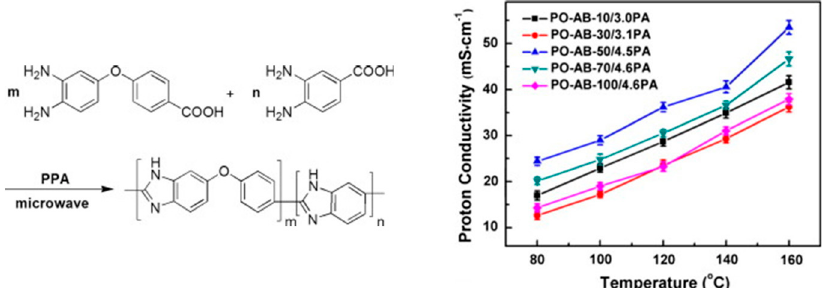
Figure 13. Synthetic route of phenoxyl-containing ABPBI ( left ) and ( right ) proton conductivity of PO-AB-x membranes as a function of temperature (PO-AB-x, x refers to the molar feed percent of 4-(3,4-diaminophenoxy)benzoic acid (DPBA) in total monomers). Reproduced from [118] with permission of Elsevier.